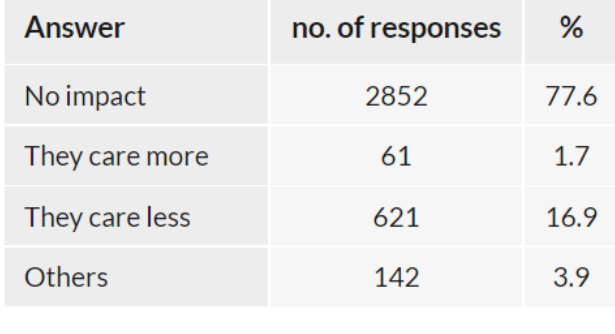
Figure 7. Impact of the pandemic on the oral care of Czech patients.